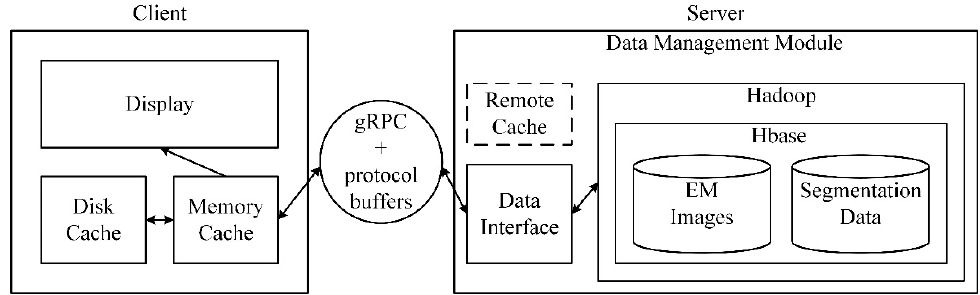
Figure 7. The architecture of the data management module. The data management module consists of two parts: an image cache module and a data storage and retrieval module. The image cache module has three levels: the memory cache, the disk cache, and the remote cache (the data at the server is considered as the remote cache). Data is stored in a distributed file system Hadoop, with a database HBase. The communication tools between clients and servers are gRPC and protocol buffers.